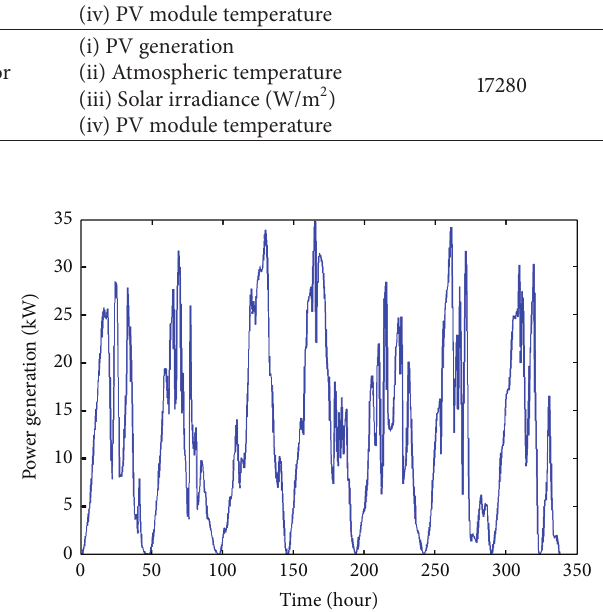
Figure 1: Photovoltaic power generation recorded at PTM Green Energy Office (GEO) Building in